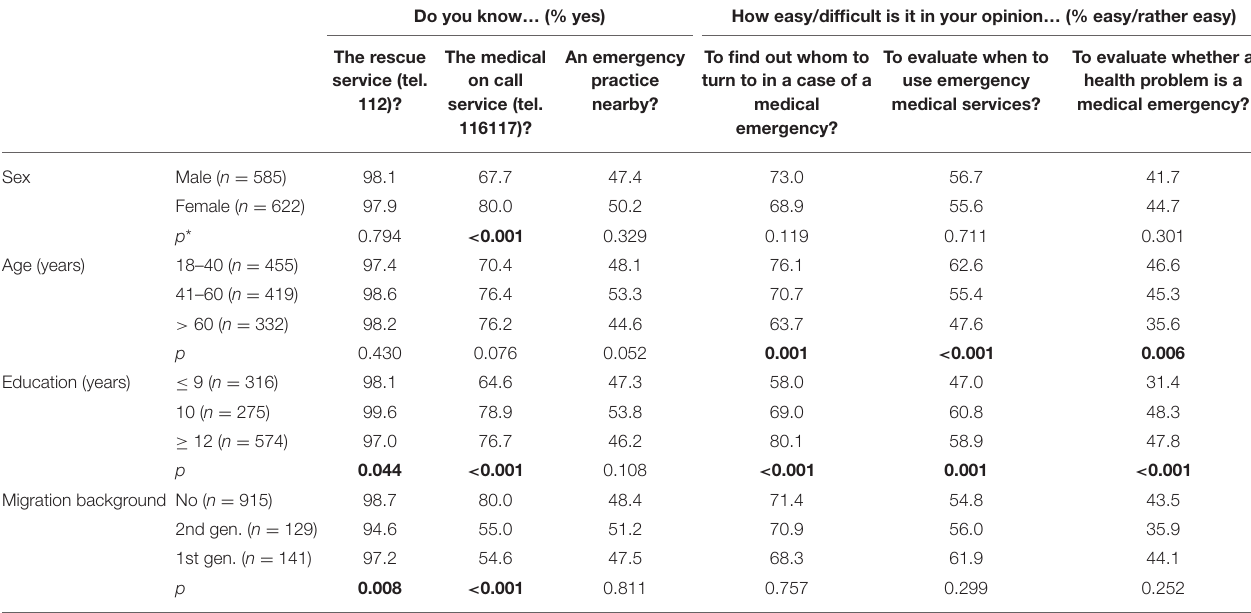
TABLE 1 | Knowledge of emergency care services and capability of dealing with emergency cases according to social factors: bivariate analyses ( N = 1,207).